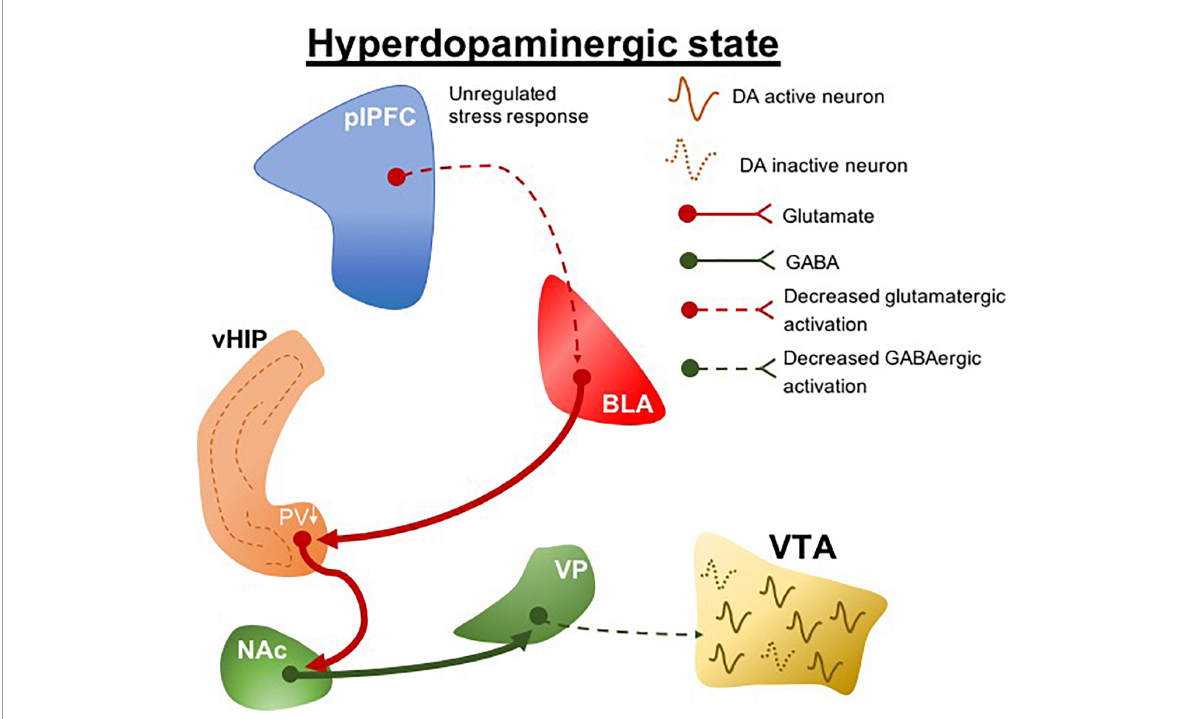
FIGURE2 plPFC-BLA stress circuit disruption during adolescence leads to hyperdopaminergic states. Unregulated stress response by plPFC hypofunction drives increased BLA activity. The increased BLA inputs to vHIP during peripuberty underlie the reduction of PV + cells which ultimately